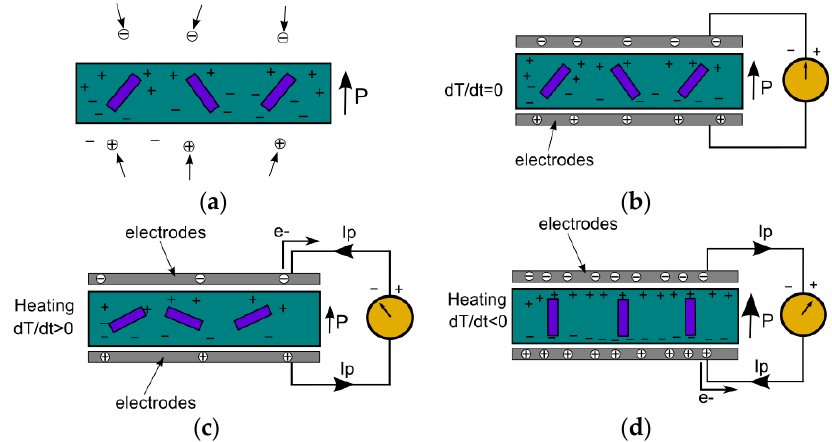
Figure 12. Pyroelectric material operation modes as capacitor dielectric. ( a ) Pyroelectric free charges; ( b ) Steady state of the harvester; ( c ) Harvester being heated, current flowing; ( d ) Harvester being cooled, current flowing. Equation (17) shows the pyroelectric current I p produced during the cycle.